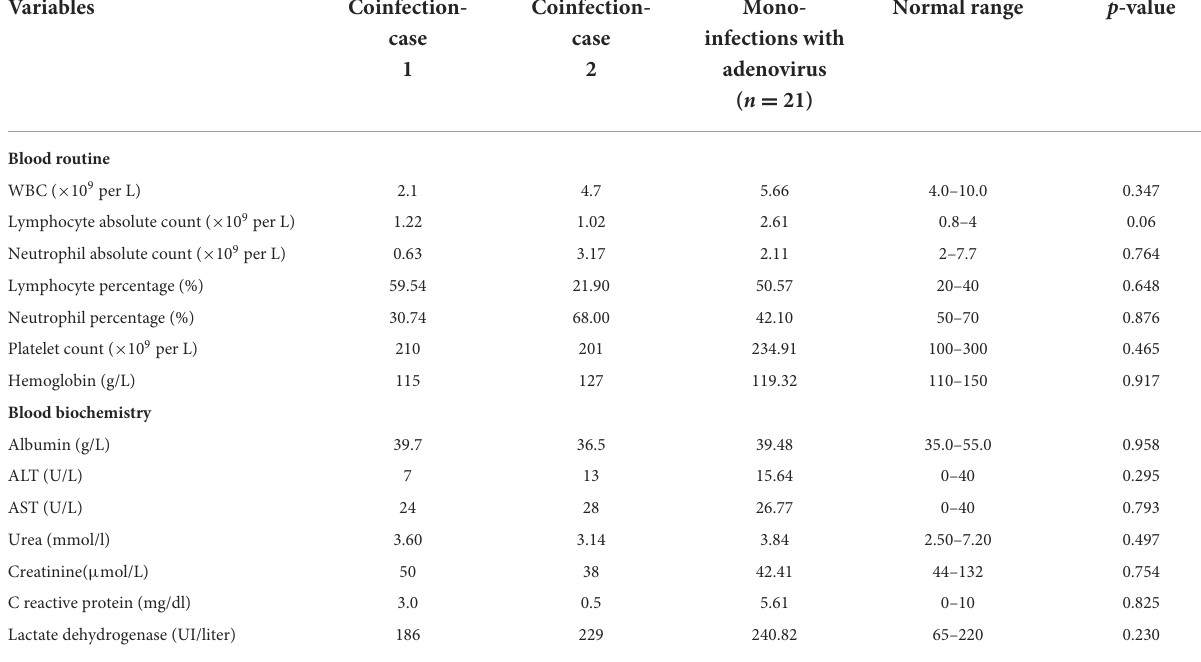
TABLE 2 Hematological and blood biochemical measurements of two children coinfected with HCoV-229E and adenovirus admitted to different rooms of the same pediatric ward and mono-infections with adenovirus in Lishui, Zhejiang Province, July–August 2019.